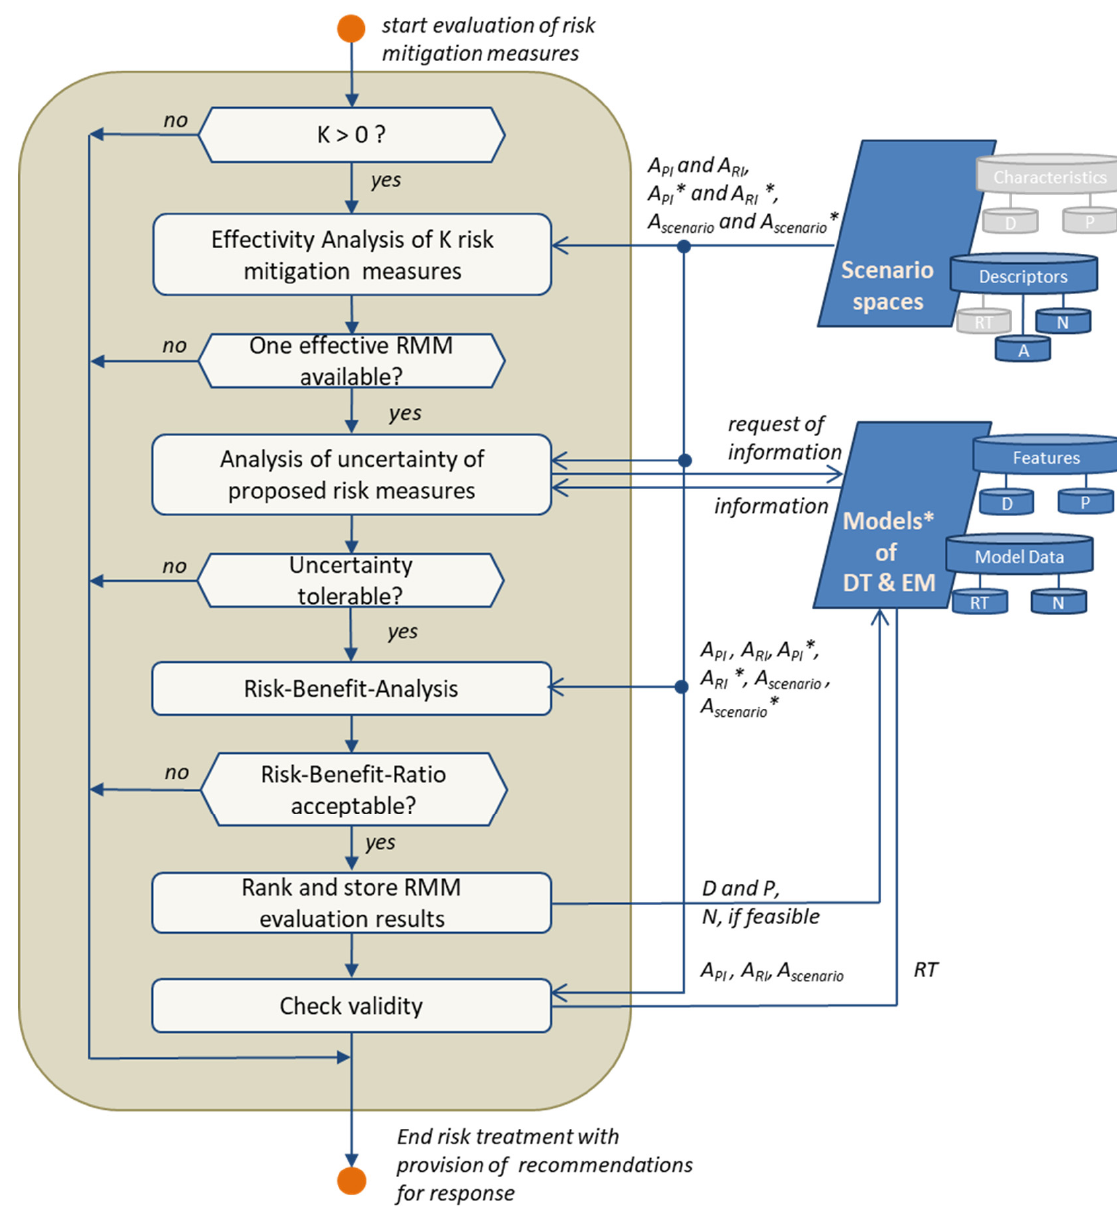
Figure 11. Flow chart for the evaluation of proposed risk mitigation measure (RMM).